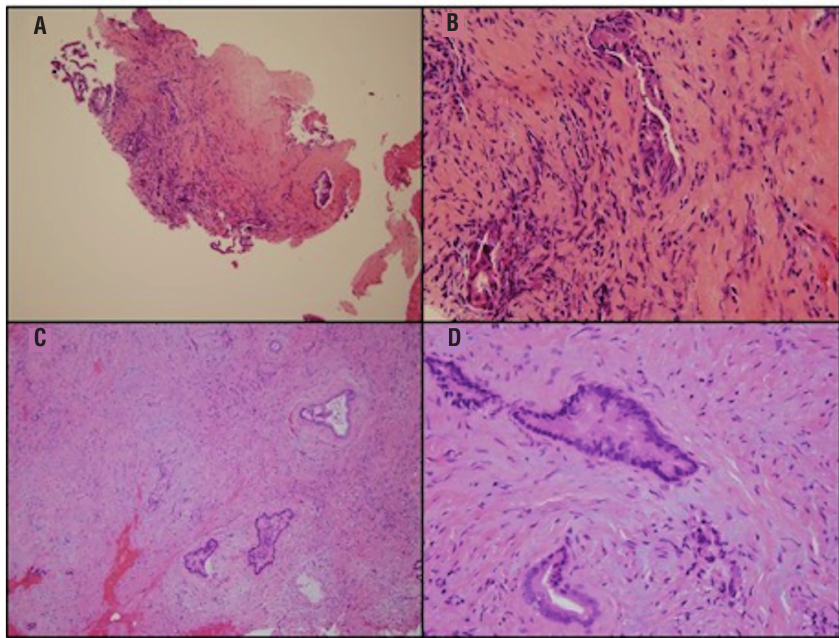
Figure-3 - Invasive moderate- to poorly-differentiated adenocarcinoma infiltrating bile duct fibrotic stroma seen in 100x (a) and 400x (b) magnifications. Right ureteropelvic junction biopsy is shown in 100x (c) and 400x (d) magnifications. Similarly, relatively bland low magnification morphology is seen in the primary (a) and metastatic (c) cholangiocarcinoma. Hyperchromasia and high nuclear-to-cytoplasmic ratios are better appreciated at higher magnification. Desmoplastic stromal response is seen around infiltrating malignant glands